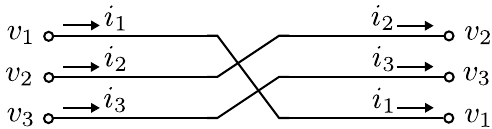
Figure 3. Representation of a line